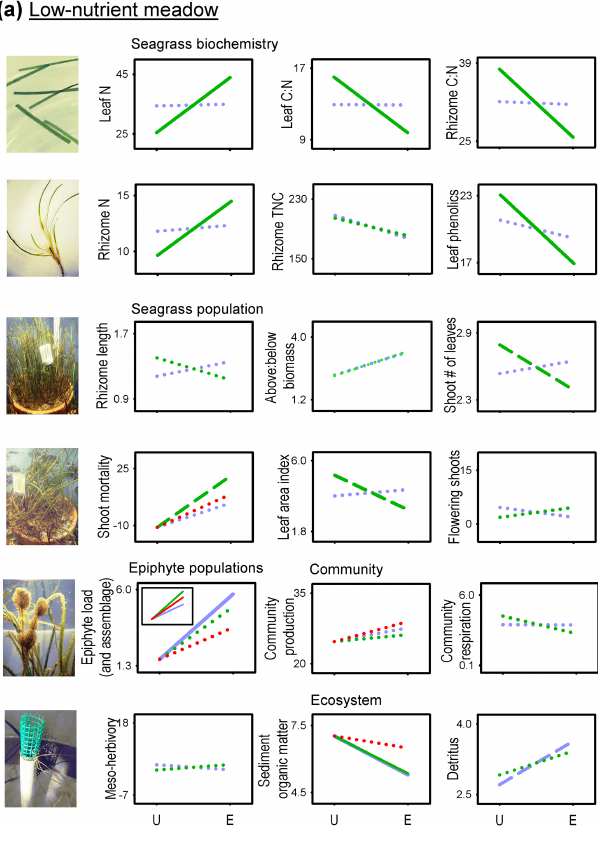
Figure 5. Summary of the effects of CO 2 (blue line) and nutri- ent (green line) additions and, when significant, of their interac- tion (red line) on Zostera noltii plant-, community-, and ecosystem- level traits of low-nutrient (a) and high-nutrient (b) meadows. Solid lines indicate significant effects on variables measured at the end of the experiment and dashed lines on variables measured through time. Dotted lines indicate no significant effects. Letters below the x axis denote unfertilized (U) and enriched (E) treatment, which is the pooled mean response to the respective enrichment over the other when there was no significant interaction (no red line). For shoot mortality and NCP in the low-nutrient meadow a significant time × CO 2 × nutrients interaction was detected and values were represented as for CO 2 × nutrients significant interactions. ∗ Appar- ent effect due to a drastic increase in unfertilized plants in relation to the initial field conditions (see